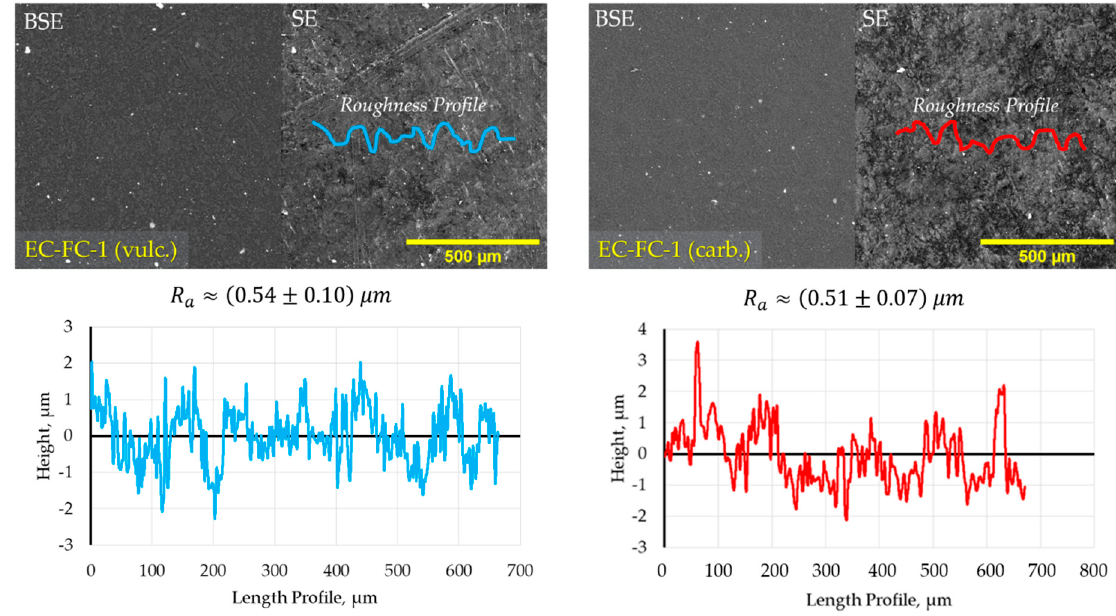
Figure 7. The roughness profile for vulcanized ( left ) and carbonized ( right ) specimens of EC-FC-1 composition. The statistics of experimentally measure Young’s modulus values for EC-FC-1 com- posite (Figure 8) returns the average value of 0.25 ± 0.02 GPa for vulcanized samples and 9.83 ± 1.10 GPa for carbonized samples; for the latter, the values of Young’s modulus occur to be quite close to the values of elastic modulus derived from tensile testing. Figure 8. The Young’s modulus distribution of vulcanized (purple) and carbonized (blue) specimens of EC-FC-1 compo- site.